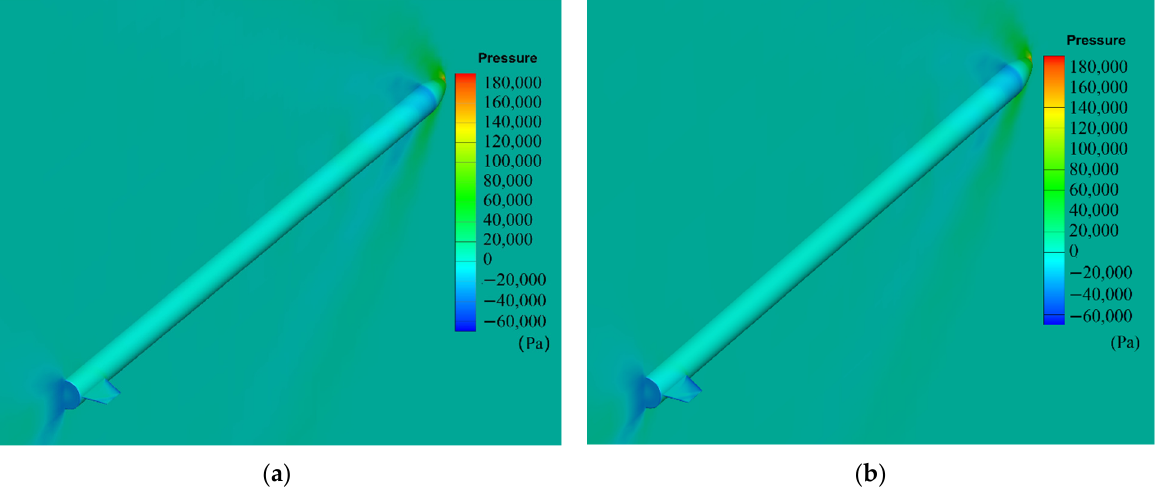
Figure 14. Pressure distribution at Ma = 1.5. ( a ) Angle of attack is 0 o . ( b ) Angle of attack is 2 o .